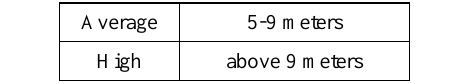
Table 2. The established sub-criteria for the height factor